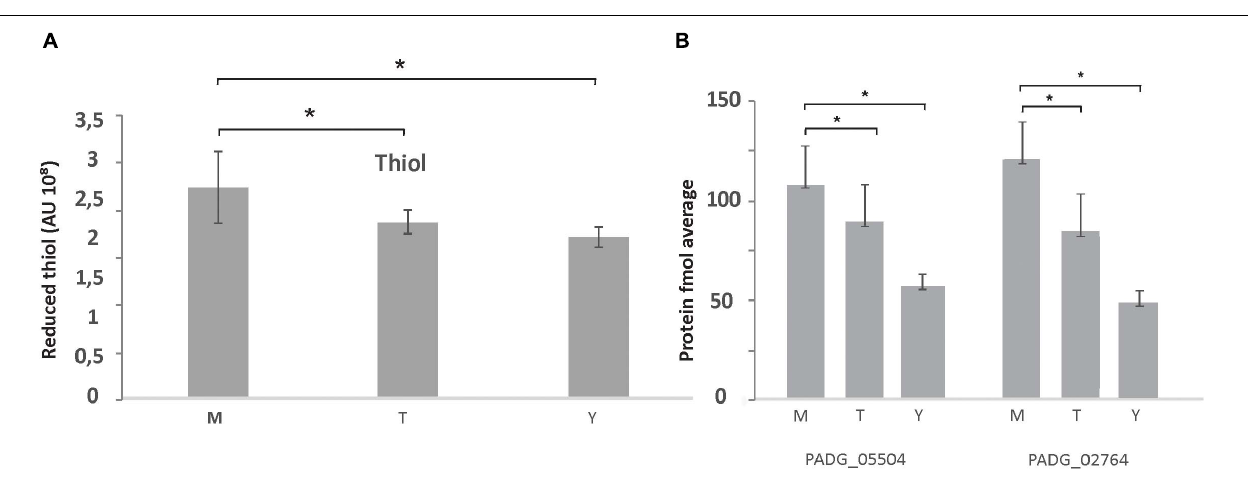
FIGURE 3 | Thiol measurements in protein extracts of mycelium, mycelium-to-yeast transition, and yeast cells. (A) Production of thiol in P. brasiliensis morphological phases: M, mycelium; T, transition mycelium-to-yeast cells; Y, yeast cells. (B) Expression levels of the proteins for PADG_05504/Trx; PADG_02764/Trx, from proteomic analysis [fmol/ µ L (log2]). ∗ Evidence statistical differences observed by Student’s t -test presenting p- value ≤ 0.05 considered